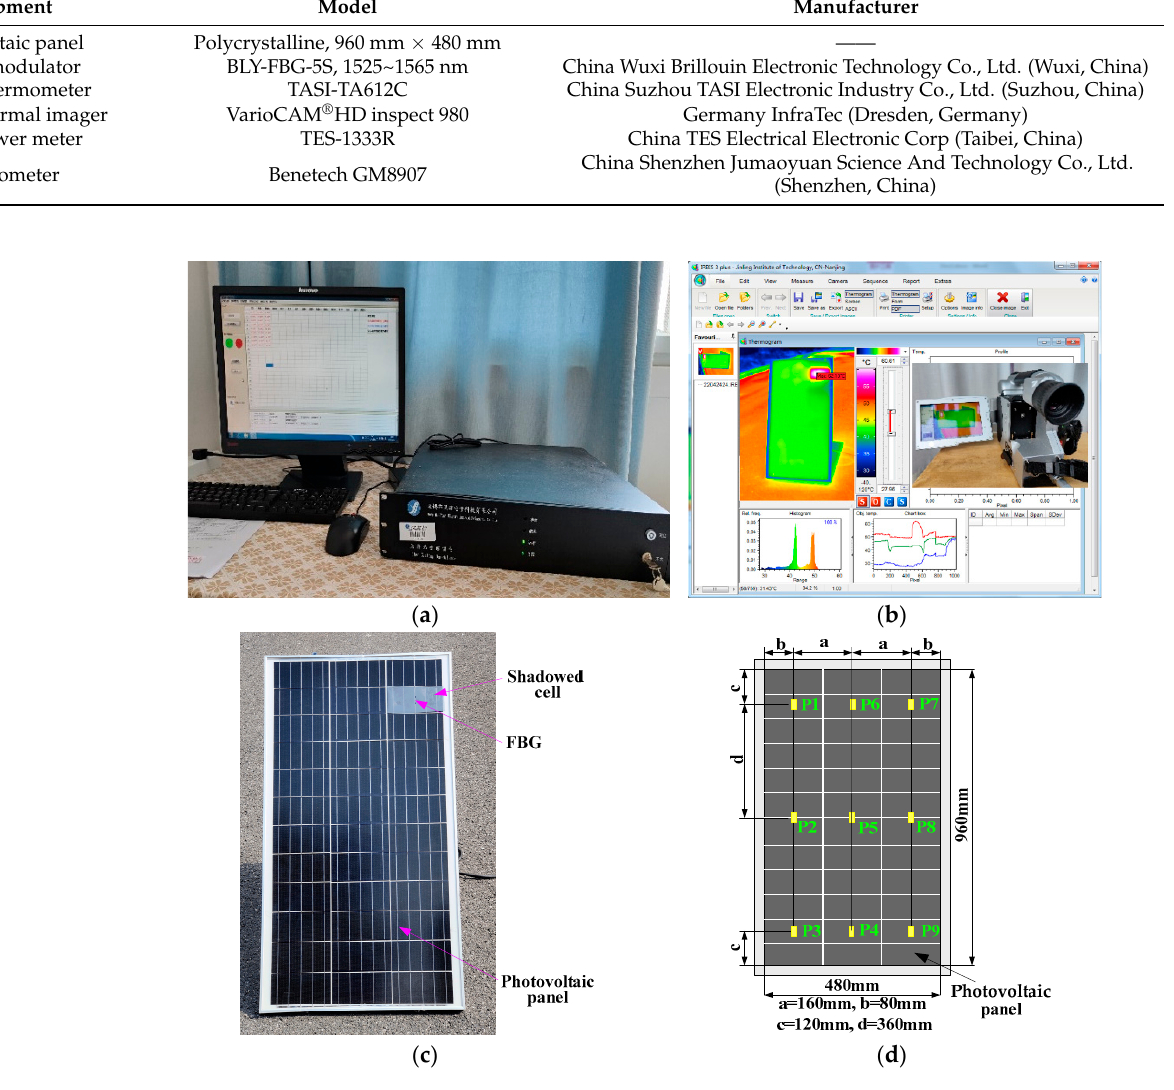
Figure 5. Experimental platform: ( a ) FBG demodulator; ( b ) infrared camera and image processing software; ( c ) photovoltaic panel and FBG layout; ( d ) temperature measurement location.